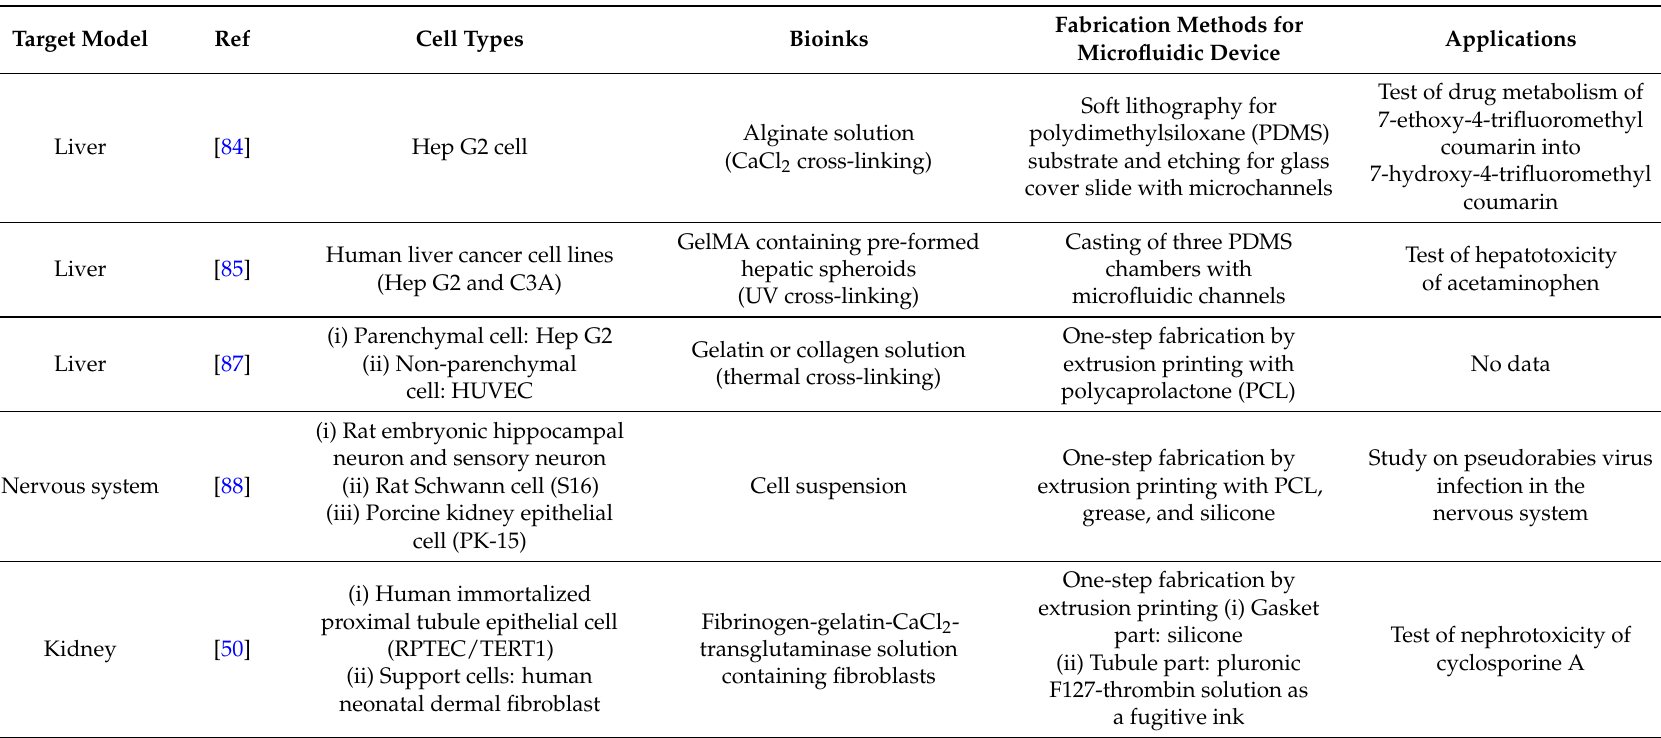
Table 2. Summary of 3D printed organs-on-chips with